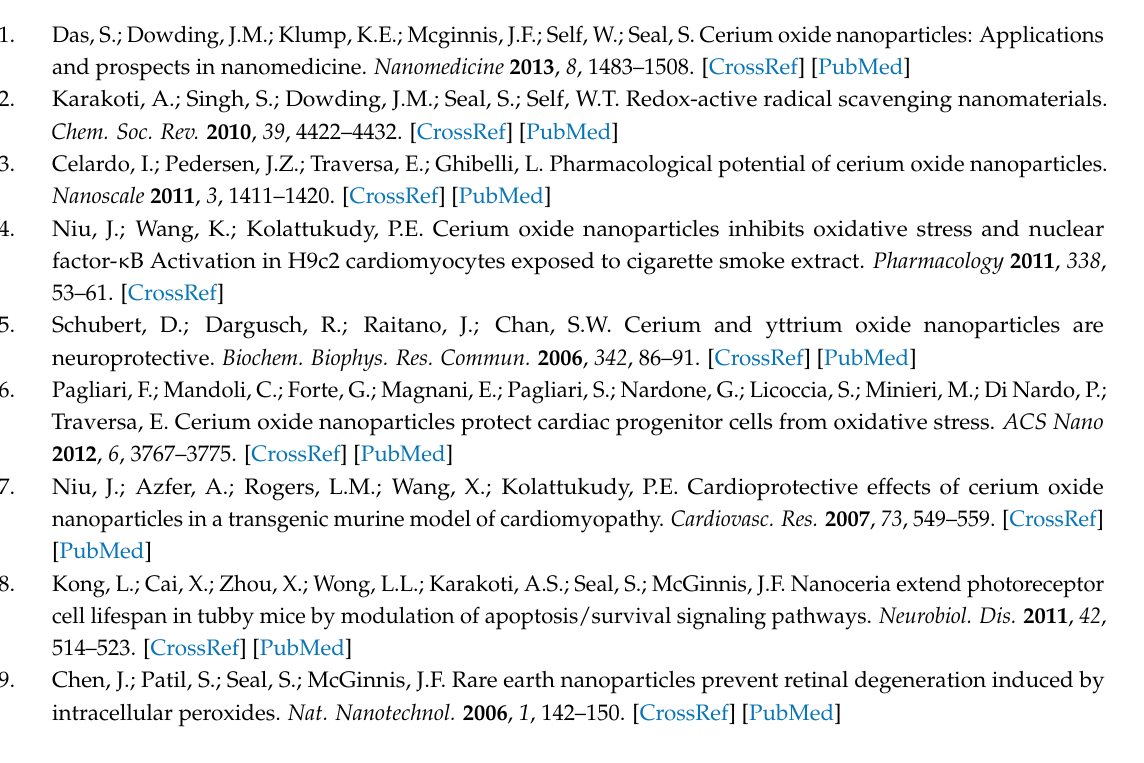
Figure S1: XPS analysis of free